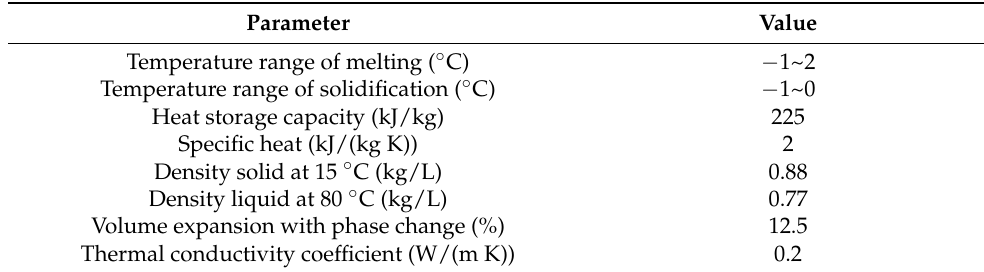
Table 1. The performance parameters of